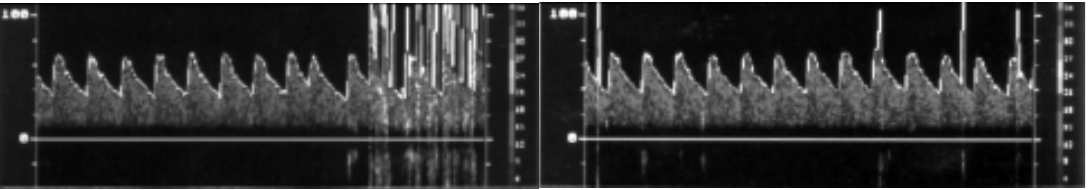
Fig. 2 - Demonstration by transcranial Doppler Ultrasonography (TDU) of the arrival of the micro-bubbles in the middle cerebral artery (arrow), after the bubbles passed by the interatrial septum during the Valsalva’s maneuver in patient Nº 35 of this series